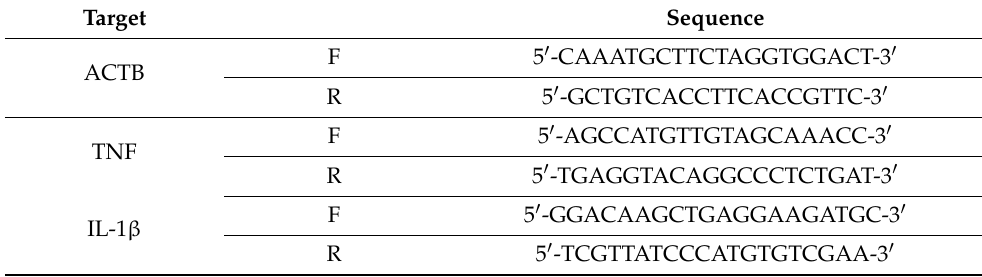
Table 1. Human primers